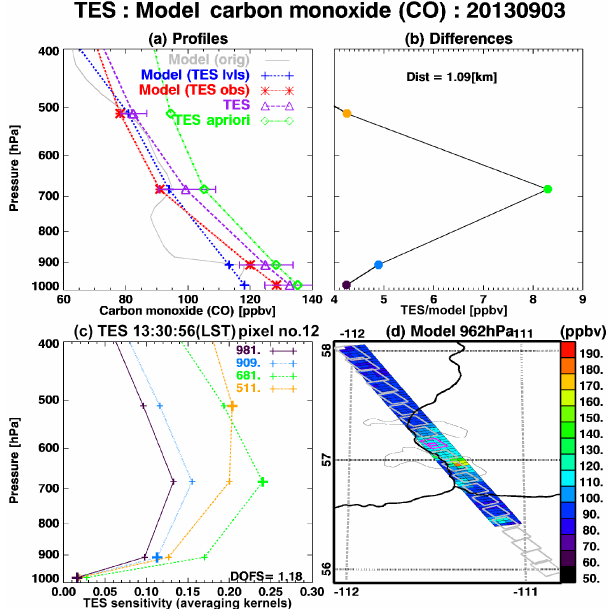
Figure 14. Summary box-and-whisker plots of the satellite and model comparisons during JOSM for CO using the same plotting convention as Fig.